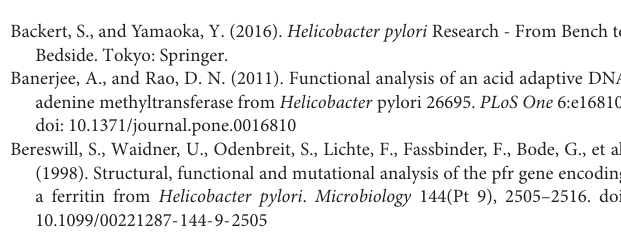
FIGURE S1 | Gene expression changes in high GACC frequency regions in the hypoPXM knockout. FIGURE S2 | Growth pattern of P12 methyltransferase gene knockouts. FIGURE S3 | Expression changes of genes in specific KEGG categories. FIGURE S4 | Gene restoration for (cid:49) hpyAXM and (cid:49) hpyPVIIM . FIGURE S5 | Effect of methylation in the regulatory and CDS regions on the transcriptome. FIGURE S6 | Transcript levels of the representative R-M systems under the control of multiple R-M systems in strain P12. TABLE S1 | Methylomes of methyltransferase knockout mutants. TABLE S2 | Genomic segments with high and low GACC abundance. TABLE S3 | Bacterial strains and plasmids used. TABLE S4 | Oligonucleotides used. TABLE S5 | qPCR for RNA-seq validation. DATASET S1 | Differential gene expression